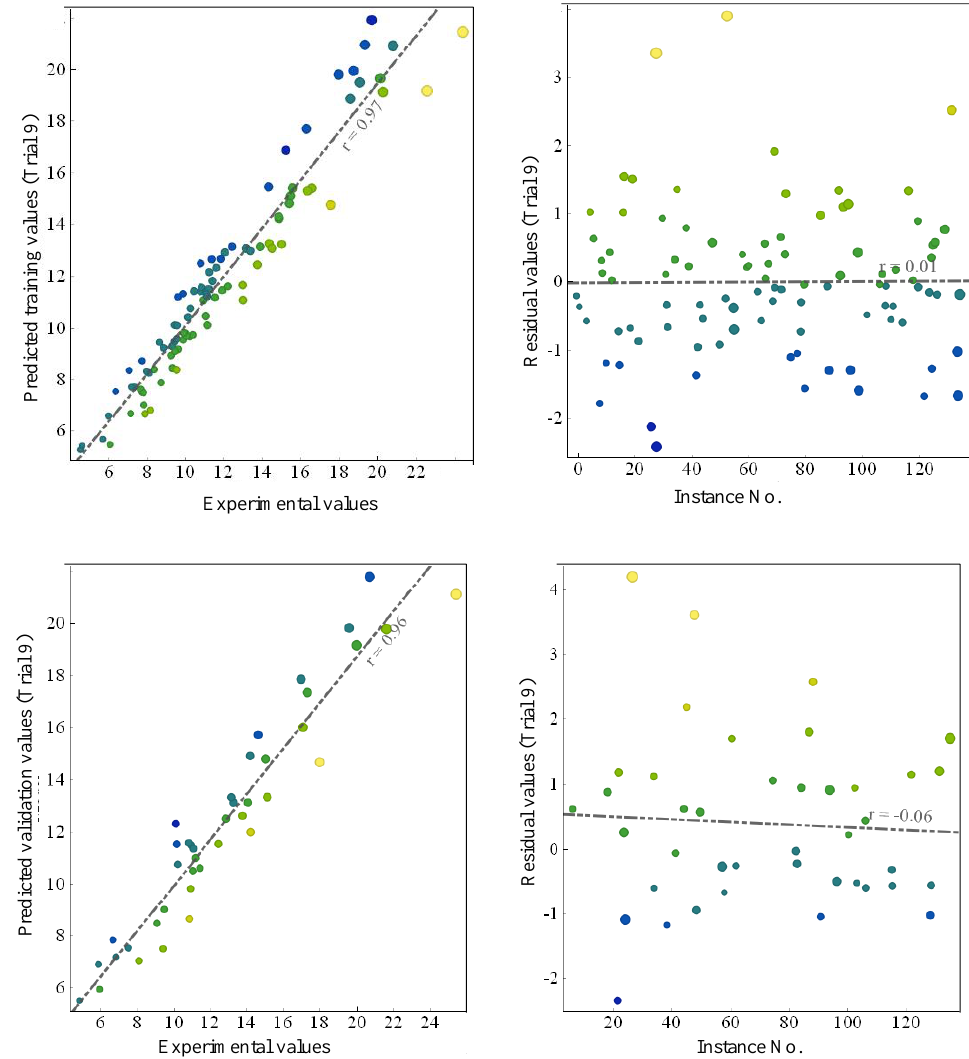
Figure 6. Regression slopes and error analysis of GEP model.